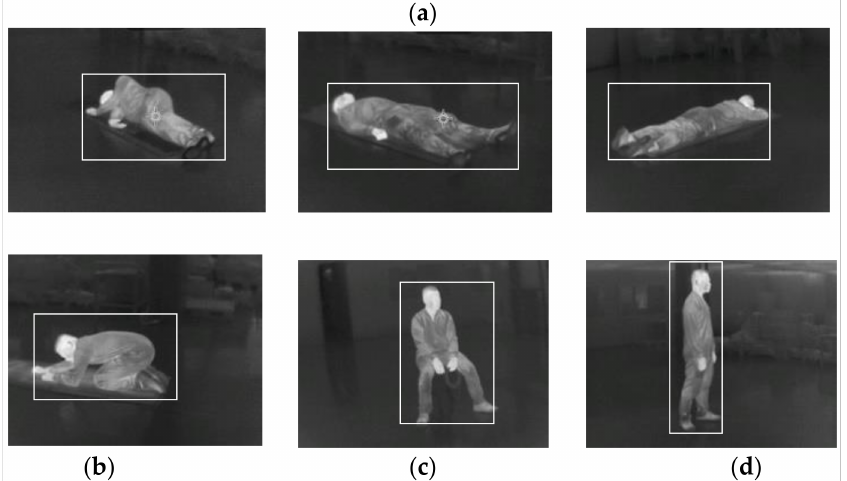
Figure 5. Flue Ti300+ self-taken images to include ( a ) side lying, lying upward, lying downward, ( b ) squatting, ( c ) sitting, and ( d ) standing postures. NFPA code 1801: Standard on Thermal Imagers for the Fire Service, 2021 edition. In NFPA National Fire Codes Online. Retrieved from